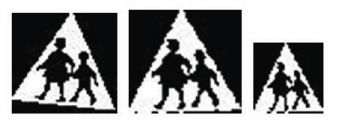
Figure 3. Normalisation of extracted traffic sign. Left: extracted traffic sign. Middle: rotation normalisation. Right: size normalisation.